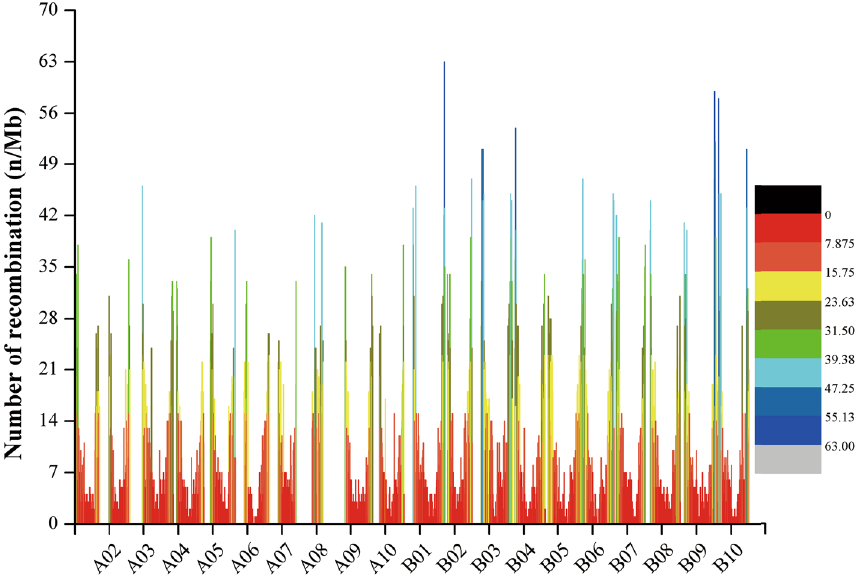
Figure 6. Recombination rates and hot spots of 49 peanut accessions. Different colors show the different recombination rates in the 49 accessions population; the recombination hot spots were defined as recombination > 25 n/Mb.